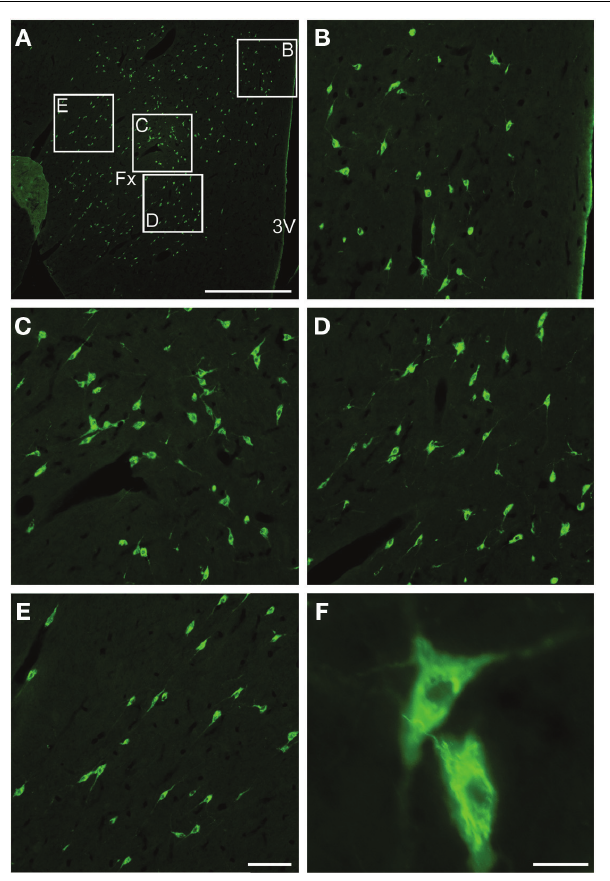
FIGURE 1 | MCHergic neurons are located in the hypothalamus of the cat. (A) Low magnification photomicrographs that exhibit MCHergic neurons at the tuberal level of the hypothalamus. (B–E) The insets in (A) are shown at higher magnification.These photomicrographs show MCHergic neurons of the dorsal hypothalamic area (B) , the perifornical region (C,D) , and the lateral hypothalamic area (E) . (F) Two MCHergic neurons are shown at high magnification.The photomicrographs were taken from 20- μ m-thick sections that were processed for immunofluorescence. FITC was used as fluorescent agent. Fx, fornix; 3V, third ventricle. Calibration bars: (A) 1mm; (B–E) 100 μ m; (F) 20 μ m.This figure was modified fromTorterolo et al.